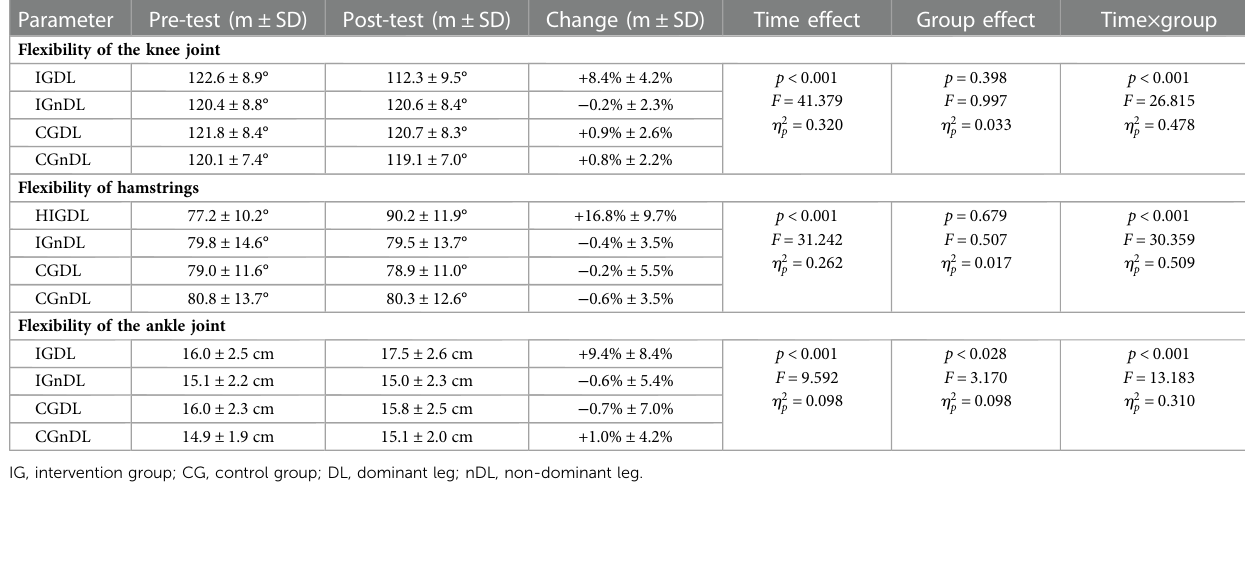
TABLE 5 Descriptive statistics and two-way ANOVA of TMG Dm and Tc. Parameter